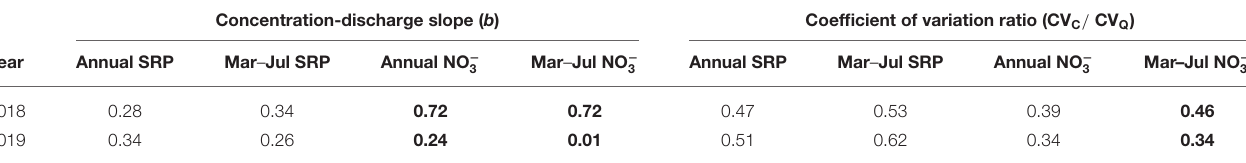
TABLE 4 | Mean annual and March–July (Mar–Jul) soluble reactive phosphorus (SRP) and nitrate (NO − 3 ) concentration-discharge slope ( b ) and concentration-discharge coefficient of variation ratio for 2018 and